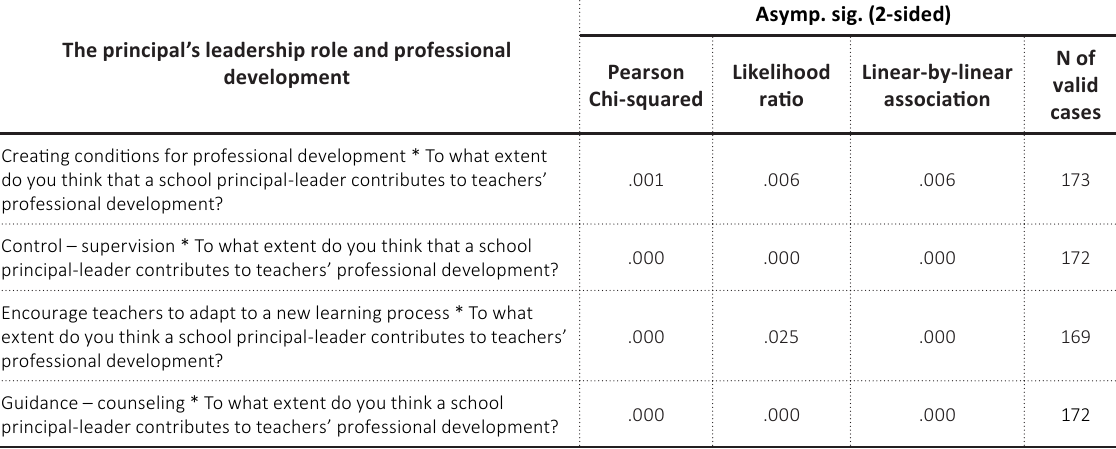
Table 4 (cont.). Chi-squared analysis for hypothesis H